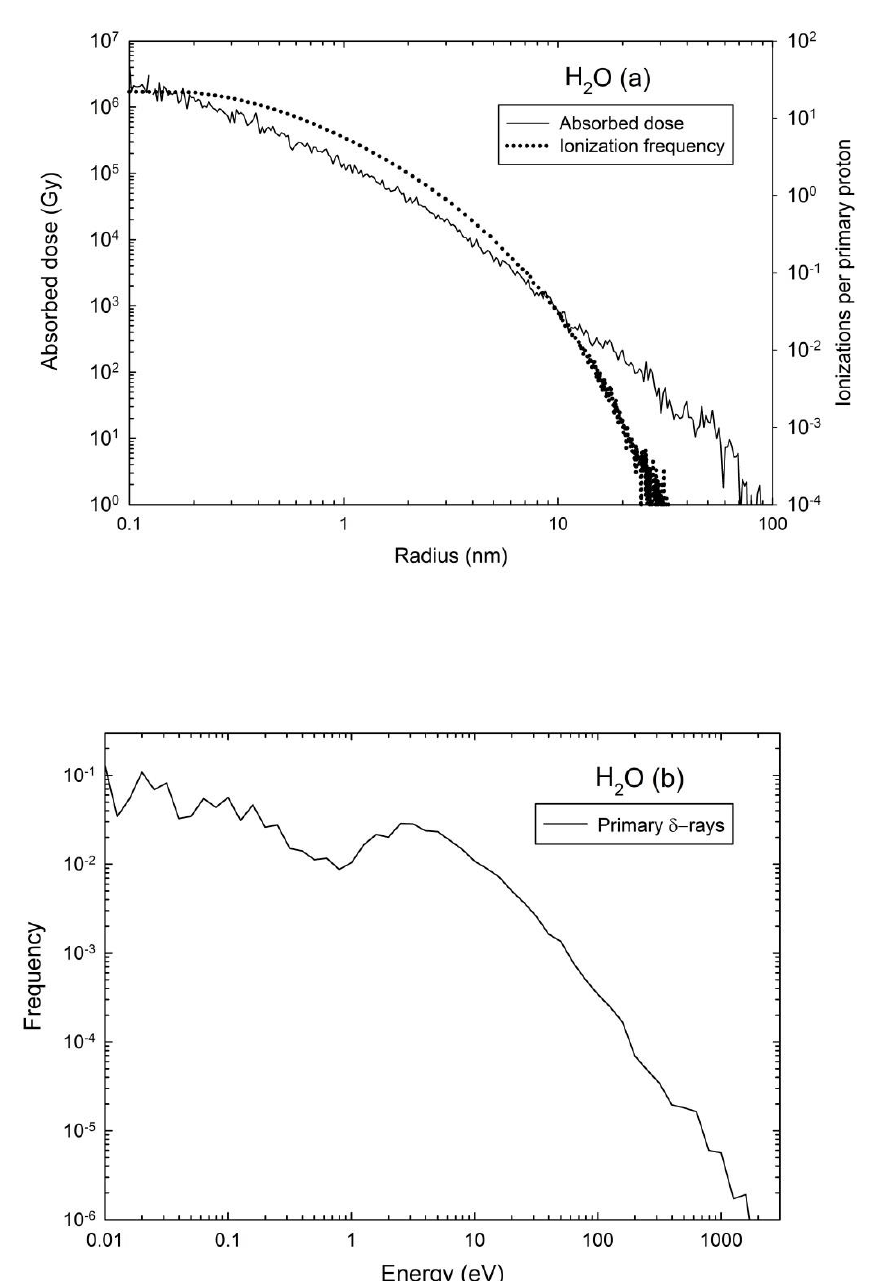
Figure 2. Radial distribution of deposited energy by ionization and electronic excitation and number of ionizations per primary 1-MeV p + ( a ) and spectrum of primary δ -rays ( b ) in water. Calculations of the radial distribution of ionizations (Figure 2a) and spectrum of emitted ions are actually carried out from forces exerted on ions under impact of 1-MeV p + , with the computed radial energy deposition profile (Figure 2a). Typical 3D snapshots of ionization tracks are shown (Figure 3). Spatial distributions of ionizations are displayed for three randomly selected proton impact events. The time evolutions of the real ( ε’) and imaginary ( ε’’) parts of the dielectric constant show th at the electric field is relaxed after ~100 fs [41,42]. Within 100 fs, a kinetic energy up to 20 eV is imparted to H 3 O + ions which move less than 6.2 nm during this time step. The time step of t = 100 fs is large enough